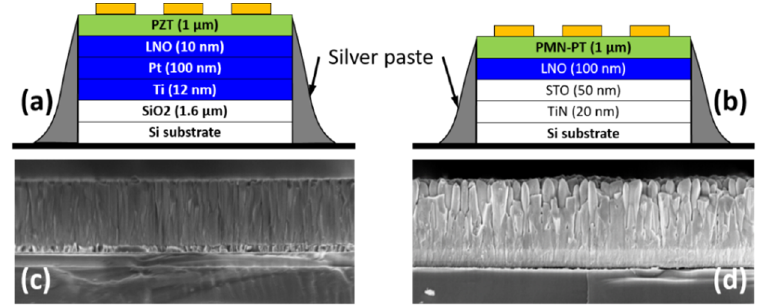
Figure 1. ( a , b ) Schematic representations of the multilayer structure of the PZT and PMN-PT samples, respectively. ( c , d ) Correspond to cross-section SEM secondary electron images using the In-Lens detector.